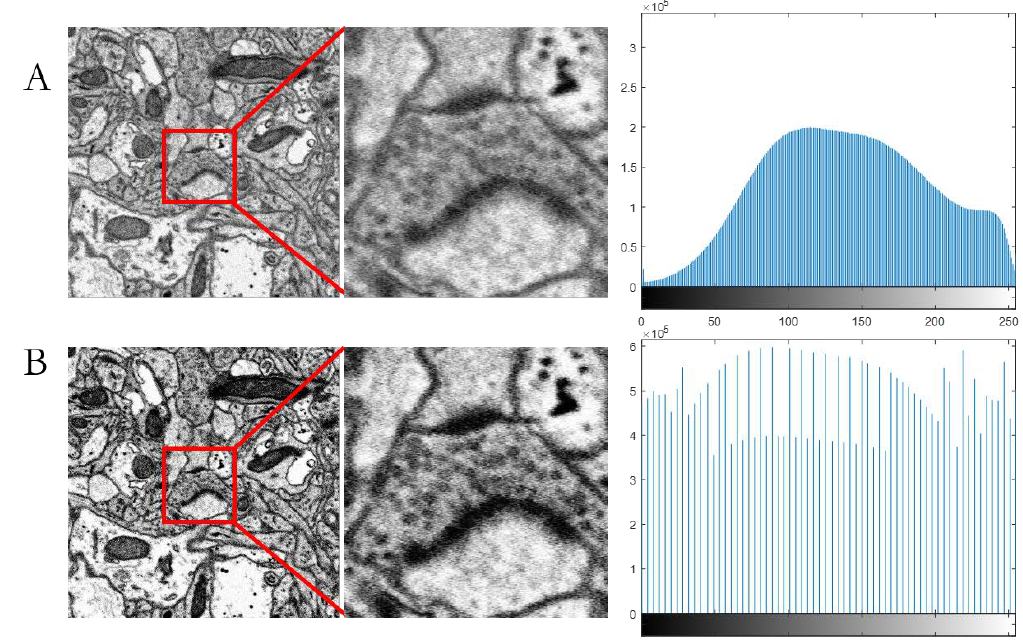
Figure 4. The raw image and image processed with histogram equalization. ( A ) Left: raw image; middle: zoomed area containing an MSB; right: histogram of the raw image; ( B ) left: image processed with histogram equalization; middle: zoomed area containing an MSB; right: histogram of the image processed with histogram